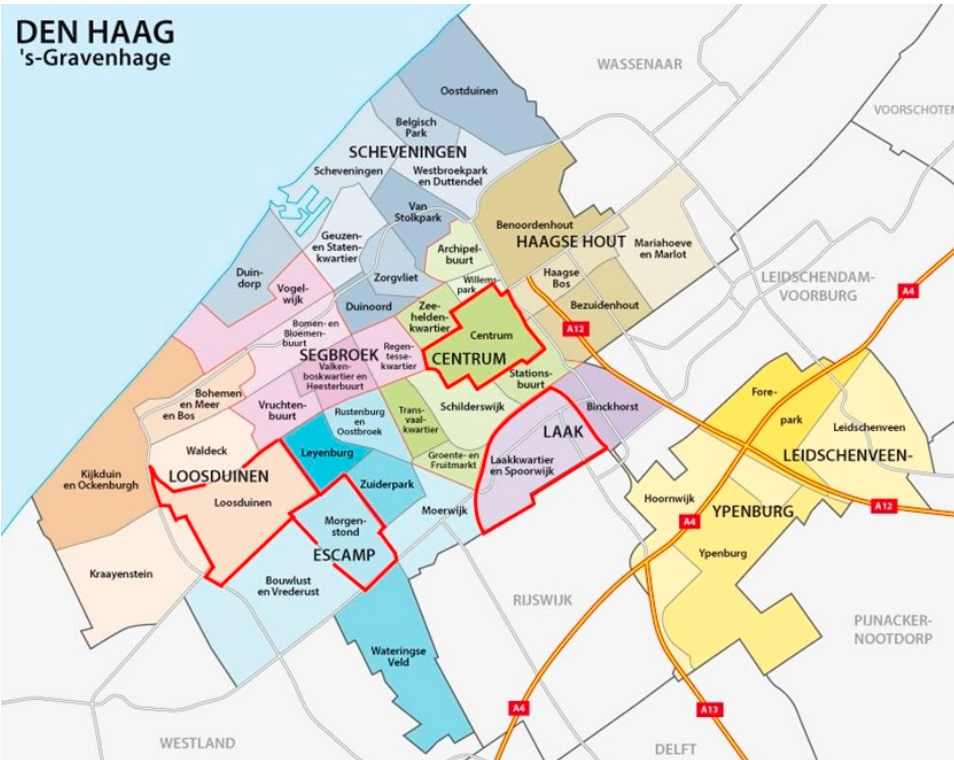
Figure 1. Administrative and political map of the municipality of The Hague. Neighbourhoods where focus groups were held are indicated by red borders. Taken and adapted from: Shutterstock stockvector-ID: 684913948. https://www.shutterstock.com/nl/image-vector/administrative-political-map-dutch-city-hague-684913948. (Permission obtained on 6 January 2021).